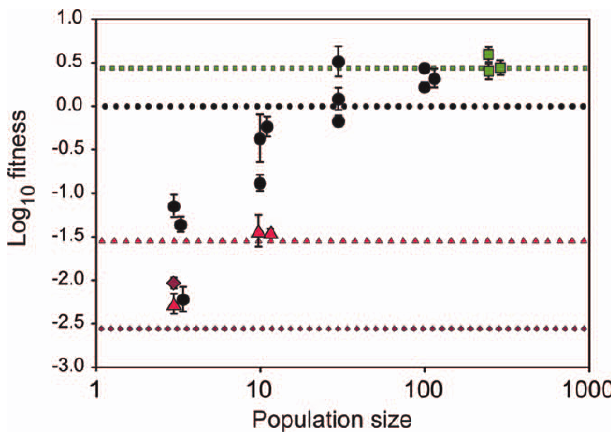
Figure 2. Changes in Mean Population Fitness Dotted lines indicate the fitness of ancestral clones: the high-fitness clone (black circles), lower fitness clones (bright red triangles and dark red diamonds), and the evolved highest fitness ancestor (green squares); this ancestor was derived from the population having the highest fitness after 90 transfers (population 100c). Each point indicates the average fitness of an evolved population, with error bars indicating one standard error. Some populations are slightly displaced on the x -axis for clarity. The population bottleneck sizes were three, ten, 30, 100, and 250. Five lineages were propagated at bottleneck sizes three and ten, and three lineages were propagated for all other bottleneck sizes. The color and shape of each point indicates the ancestral clone from which that population was derived. The fitness of the high-fitness ancestor was set equal to zero on a log 10 scale, and all other fitness values are relative.